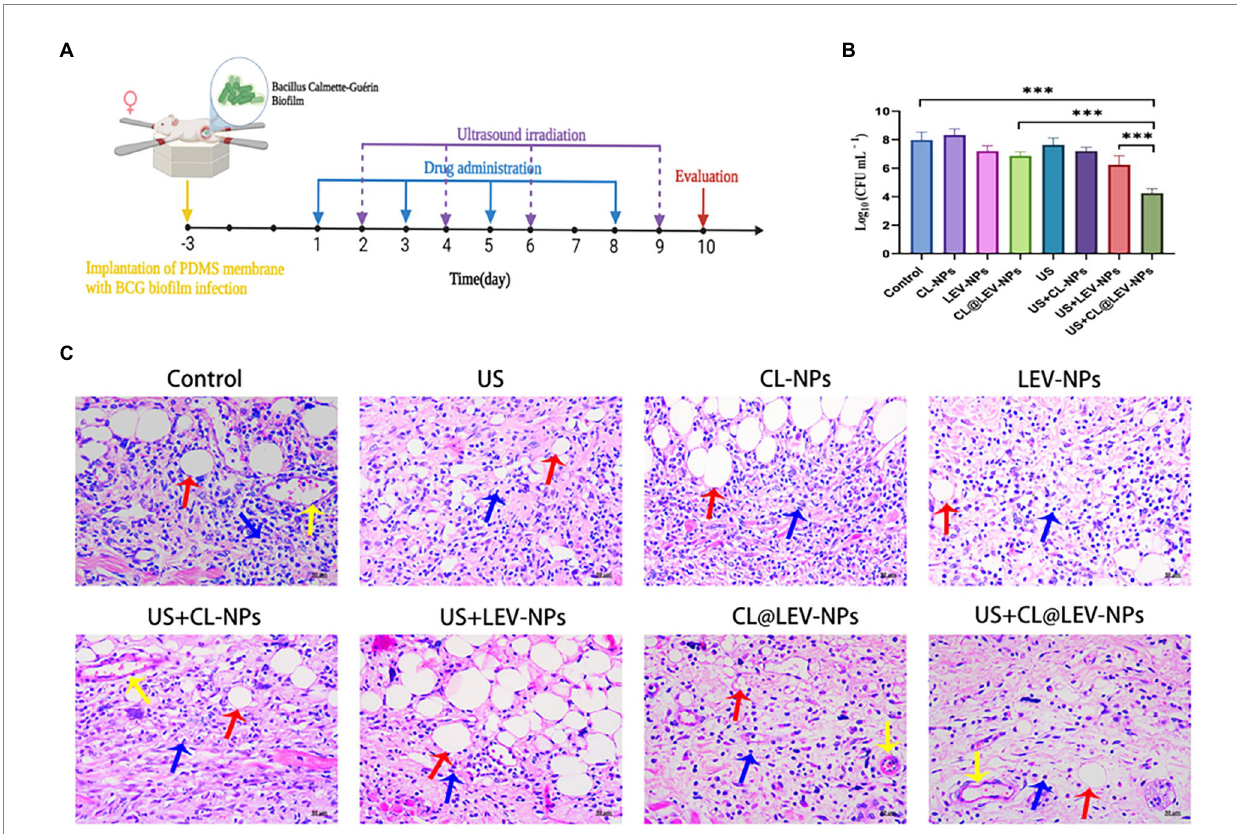
FIGURE 9 In vivo biofilm infection treatment. (A) Schematic diagram of the treatment of BCG biofilm infection; (B) The bacterial plate count of the surrounding tissue of the mice in each group after the treatment, *** p < 0.001; (C) Under different treatment methods HE-stained images of surrounding tissues (blue arrows: inflammatory cells, red arrows: subcutaneous fat, yellow arrows: blood vessels), scale bar 50 μ m